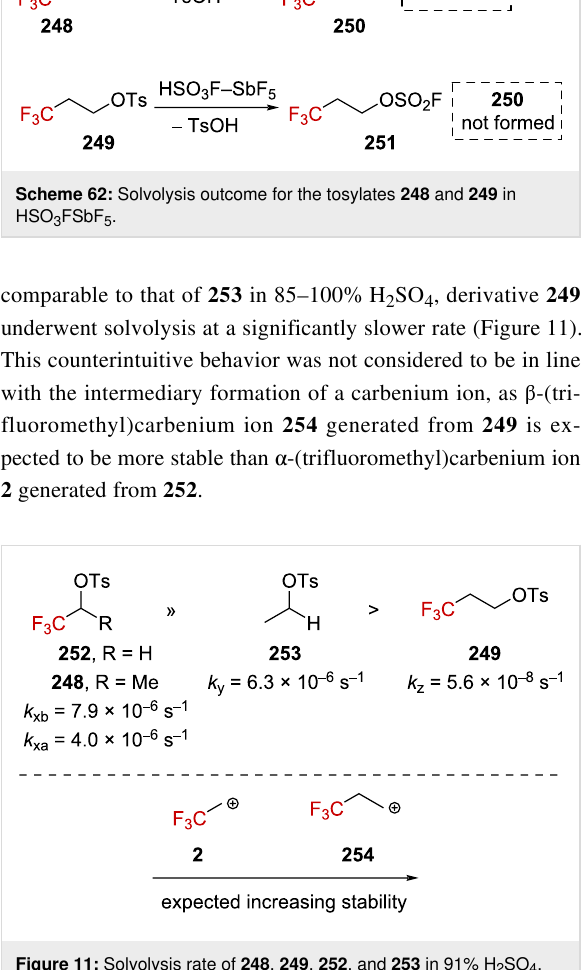
To rationalize this trend under these reaction conditions, the authors submitted the enantioenriched alcohol (+)- 255 ([ α ] 365 25 +2.682, the absolute configuration was not mentioned) to two distinct reaction pathways (Scheme 63). No erosion of the spe- cific rotation, neither through path ABDE ([ α ] 365 25 +2.692), nor CDE ([ α ] 365 25 +2.679) was observed, suggesting that an α -(tri- fluoromethyl)carbenium ion cannot be considered as a reactive